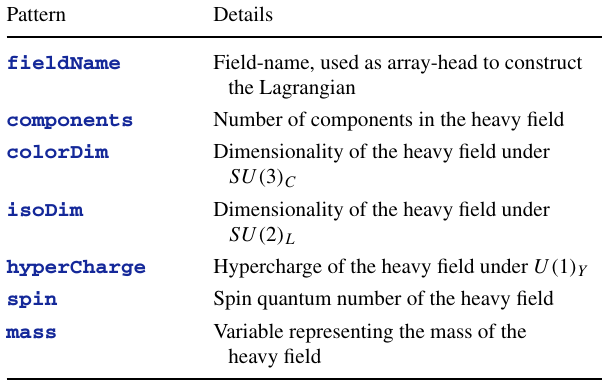
Table 3 Generic form of individual fields